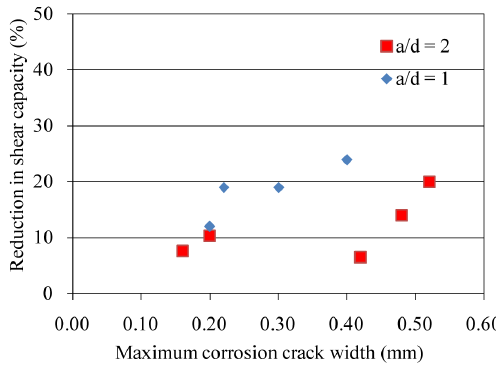
Fig. 12. Variation of reduction in shear capacity with maximum corrosion crack width